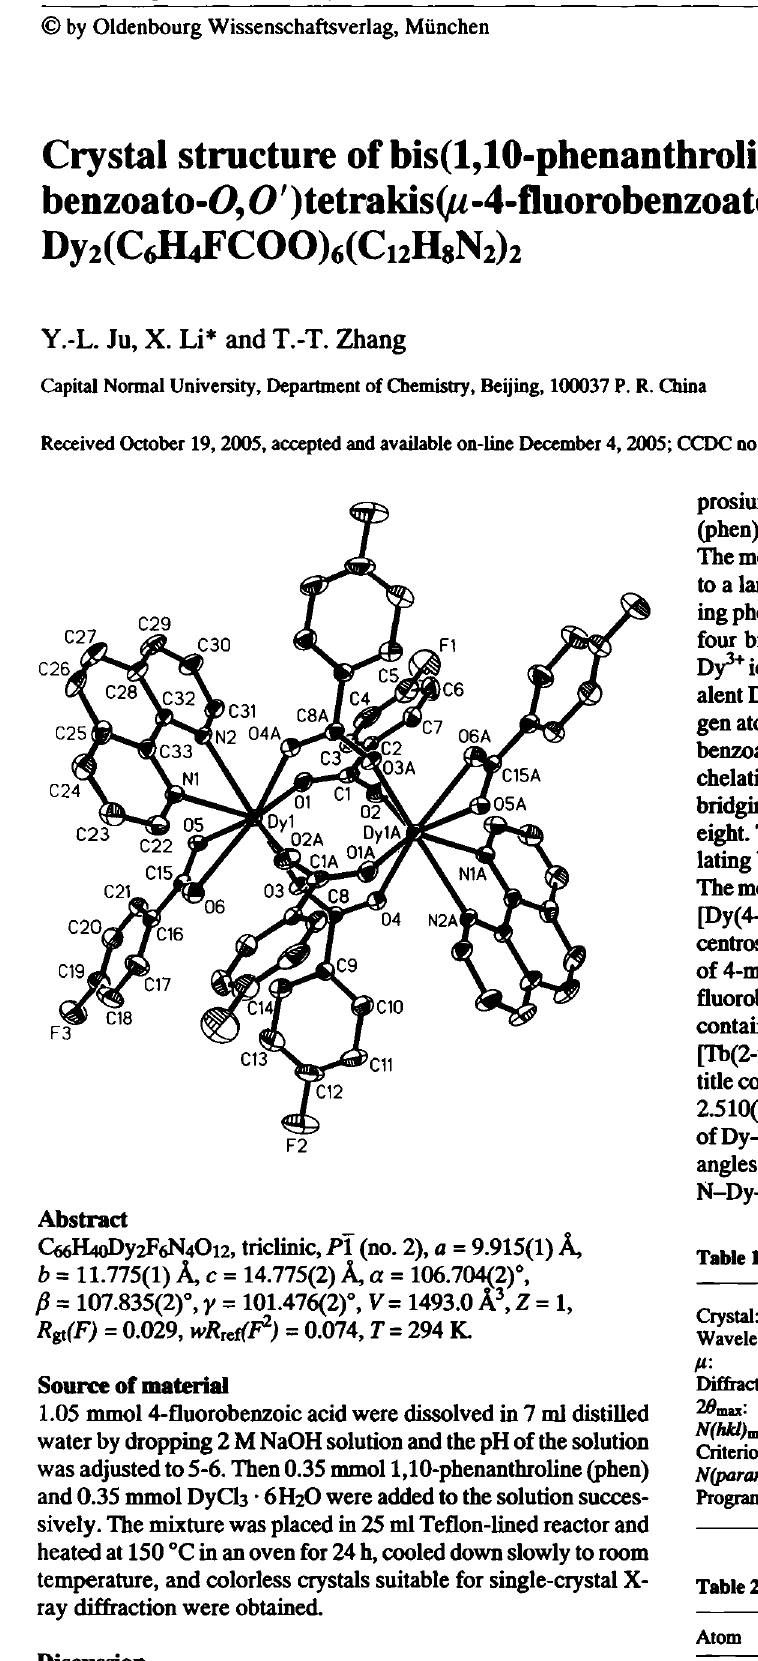
Table 2. Atomic coordinates and displacement parameters (in A 2